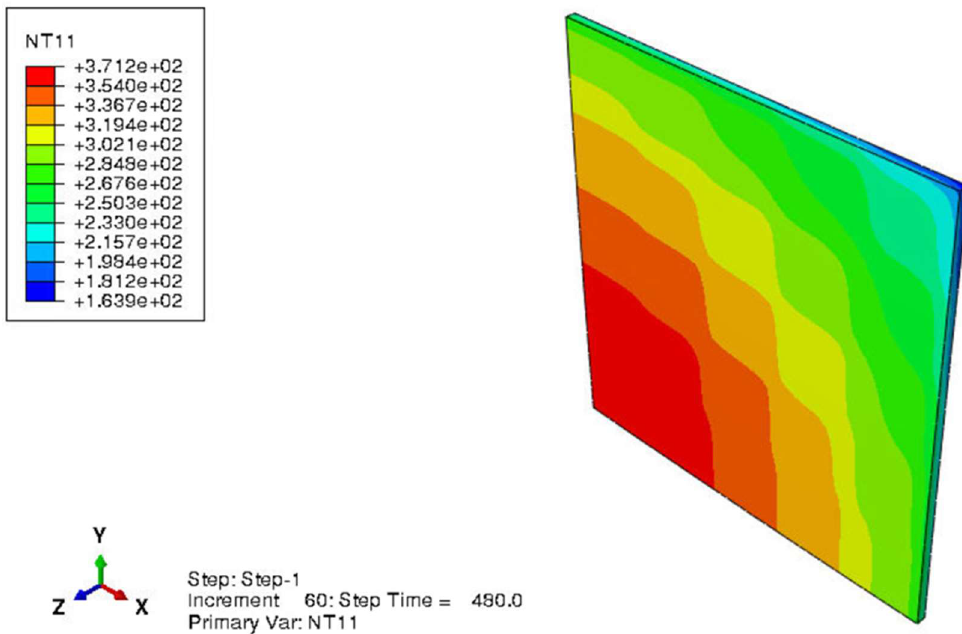
Figure 17. Surface temperature distribution (°C) at t = 480 s (6 mm specimen).